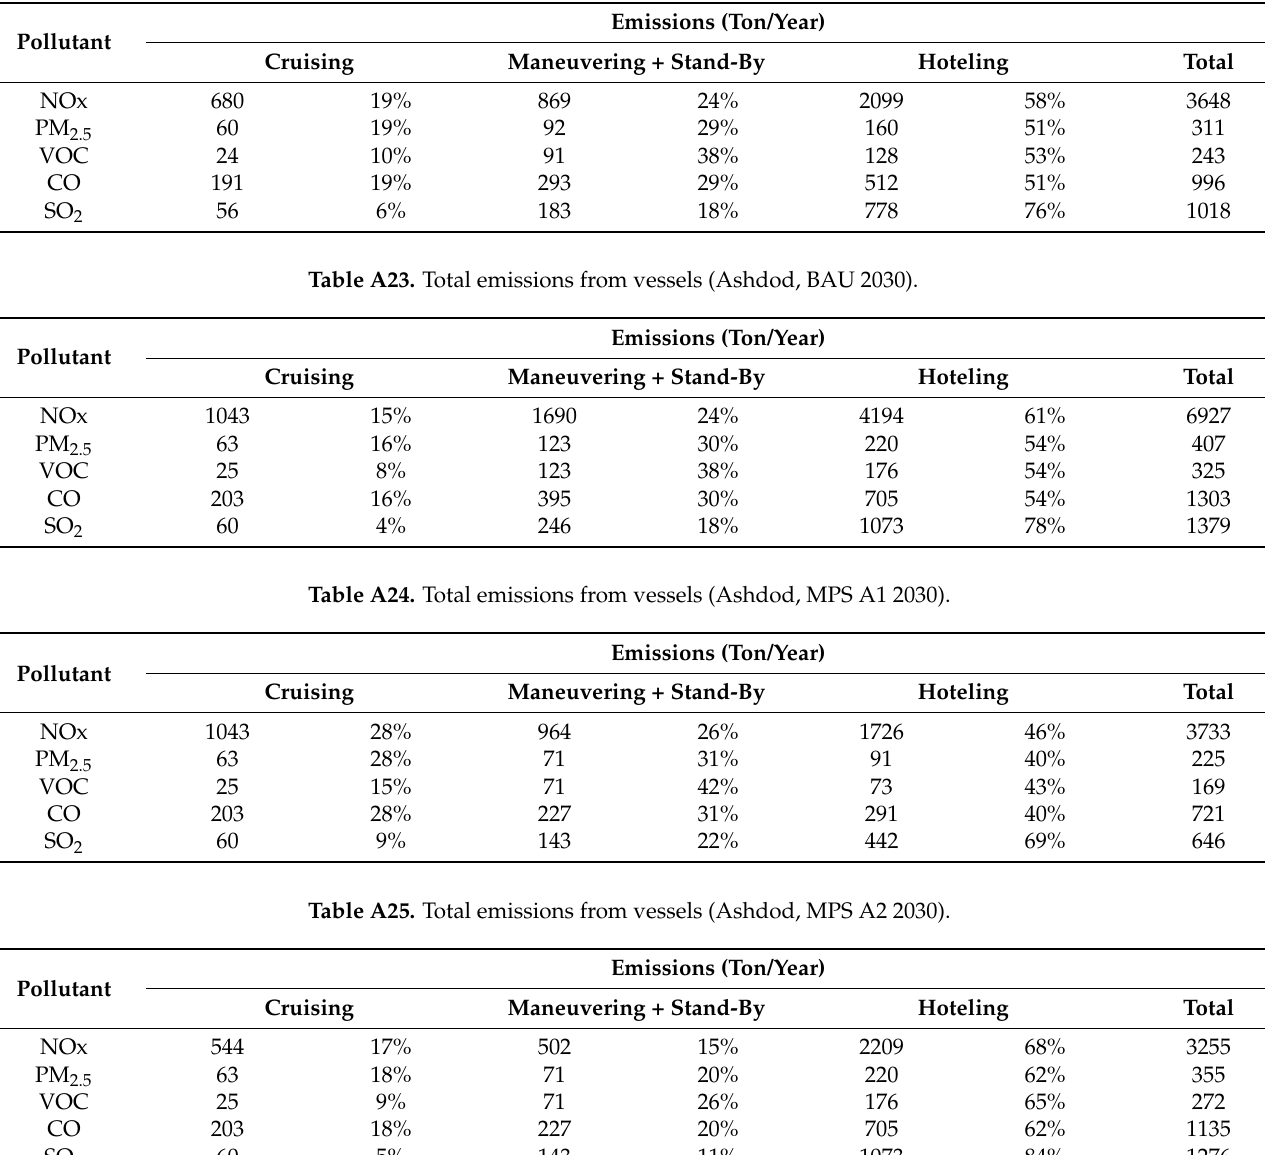
Table A22. Total emissions from vessels (Ashdod, MPS 2025).